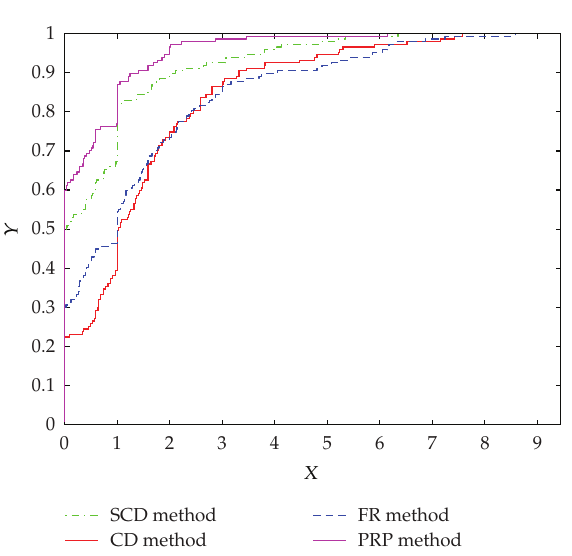
Figure 1: Performance profiles of the given methods with respect to CPU